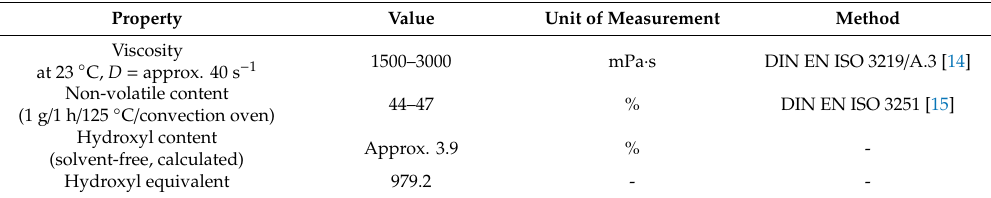
Table 1. Physical and chemical properties of polyhydroxyacrylate dispersion Bayhydrol A 2470.